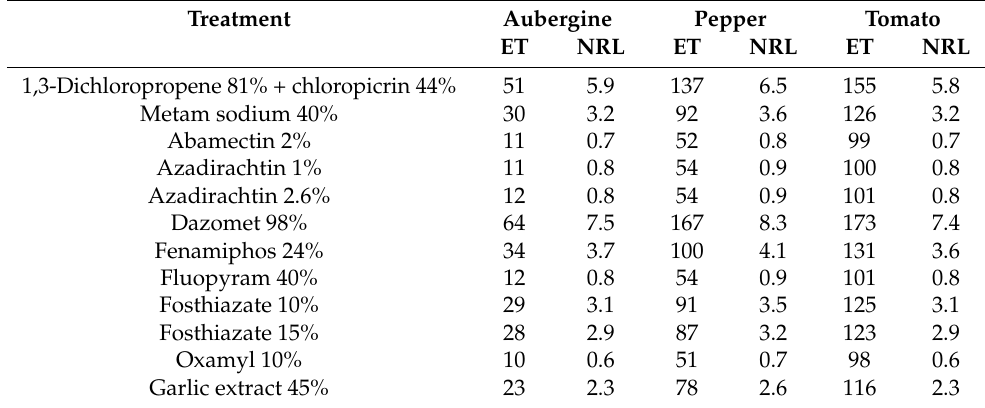
Table 4. Root-knot nematode ( M . incognita ) economic threshold (ET) and net return losses (NRL) at ET for various nematicidal treatments in intensive solanaceous cultivation. Treatment Aubergine Pepper Tomato ET NRL